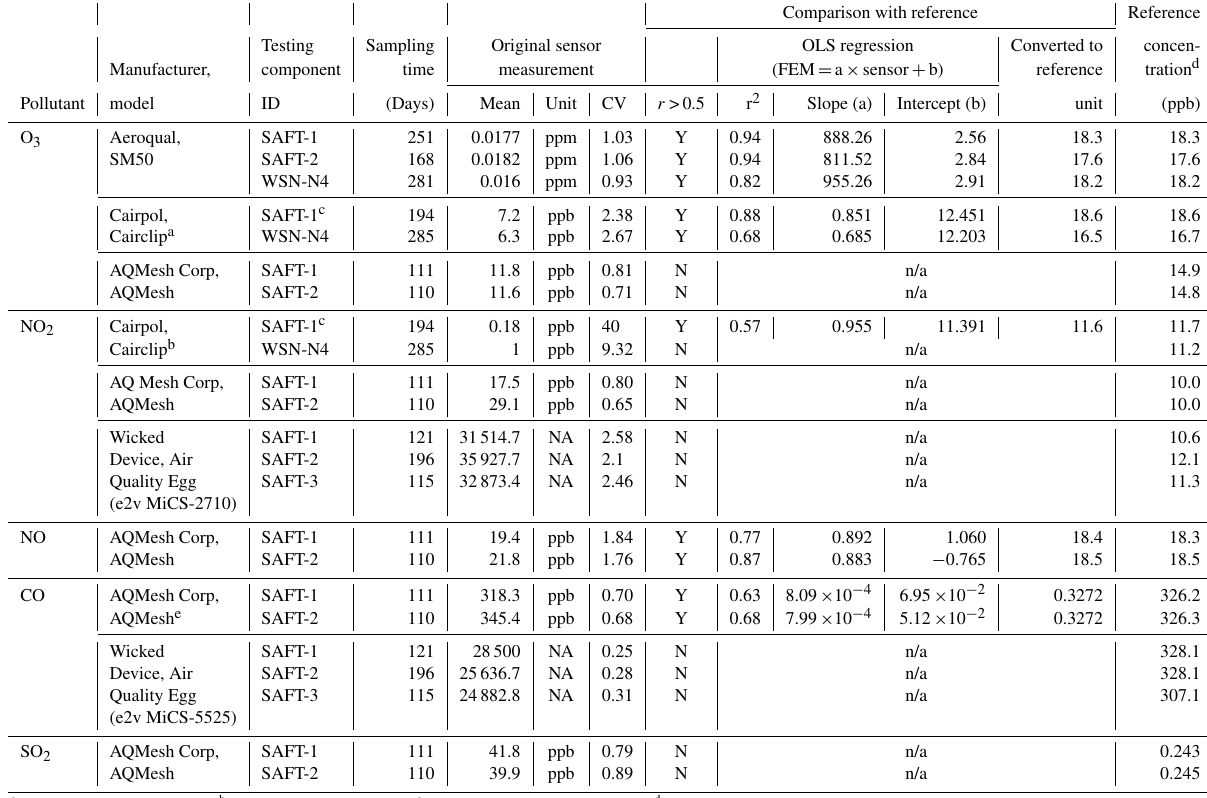
Comparison with reference